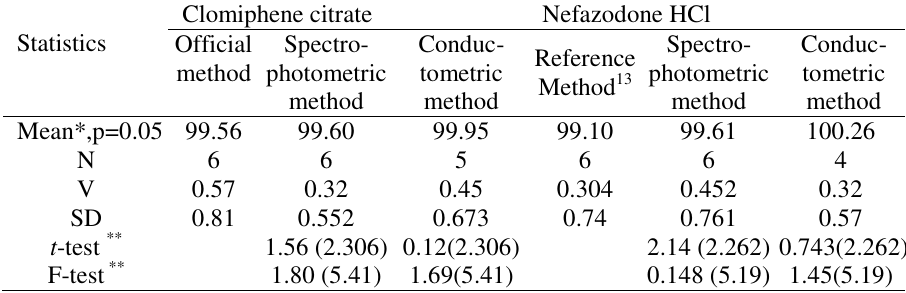
Table 8. Determination of clomiphene citrate and nefazodone HCl through complexation with ammonium reineckate using Spectrophotometric method compared with official and reference